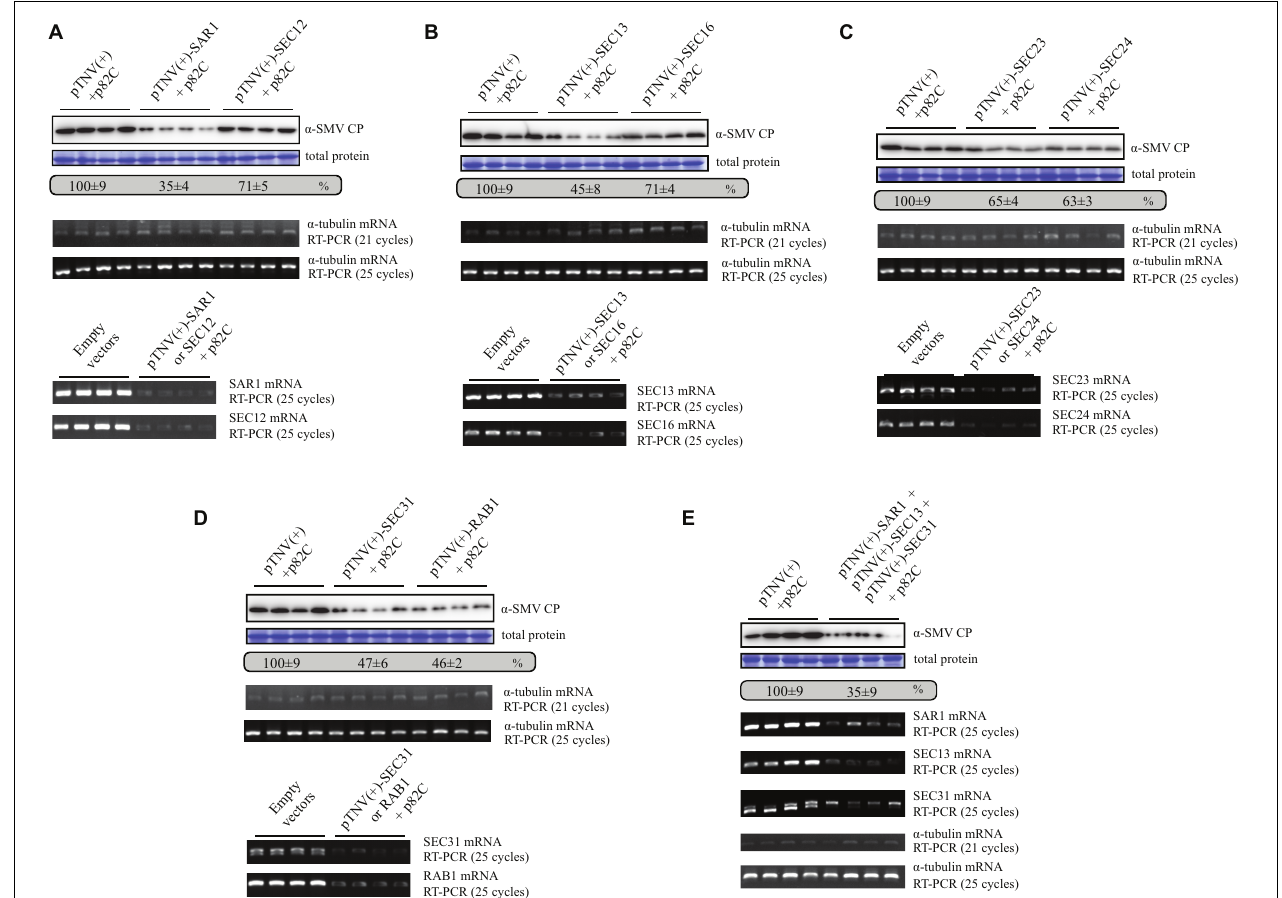
FIGURE 5 | Silencing of genes involved in COPII vesicle forming and biogenesis leads to suppressed SMV replication. (A) SMV accumulation in samples infiltrated with SMV infectious clone (OD 600 of 0.2) and empty VARS vectors (pCB301-314-pTNV(+)-RZ and pGD-2 × 35S-L-TNV-p82C) (OD 600 of 0.4, each) or VARS vectors for SAR1 or SEC12 silencing (OD 600 of 0.4, each) was measured by Western blotting at 5 dpi. Total protein loadings were shown as Coomassie blue-stained gel (upper panels). Semiquantitative PCR analysis was performed to measure the mRNA levels of α -tubulin coding gene (middle panels), SAR1 , or SEC12 (lower panels) in the SMV-infected leaves 5 days after viral infection. The number of PCR cycles is shown. (B) SMV accumulation in leaves silenced for SEC13 or SEC16 . See further details in panel (A) . (C) SMV accumulation in leaves silenced for SEC23 or SEC24 . See further details in panel (A) . (D) SMV accumulation in leaves silenced for SEC31 or RAB1 . See further details in panel (A) . (E) SMV accumulation in leaves silenced for SAR1 , SEC13 , and SEC31 . Agrobacteria transformed with vectors expressing pTNV(+)-SAR1, pTNV(+)-SEC13, or pTNV(+)-SEC31 were combined (OD 600 of 0.16, each) and coinfiltrated with pGD-2 × 35S-L-TNV-p82C (OD 600 of 0.4) and SMV infectious clone (OD 600 of 0.2). See further details in panel (A)